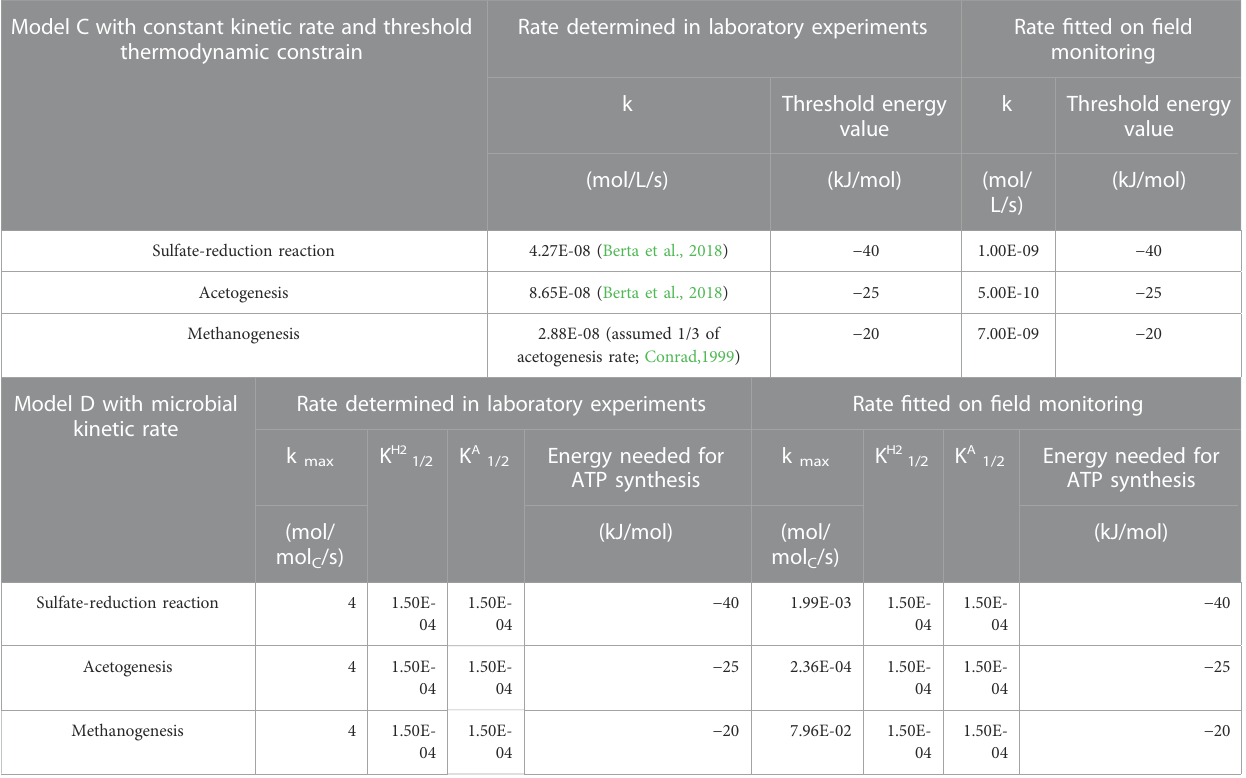
Model D with microbial kinetic